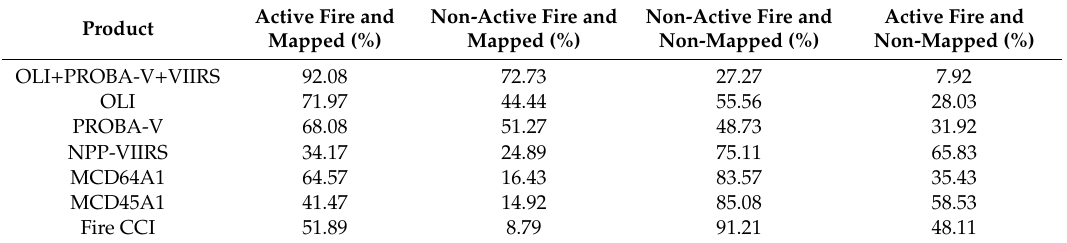
Table 3. Percentages of grid cells compared by burned area detection and active fire observations.